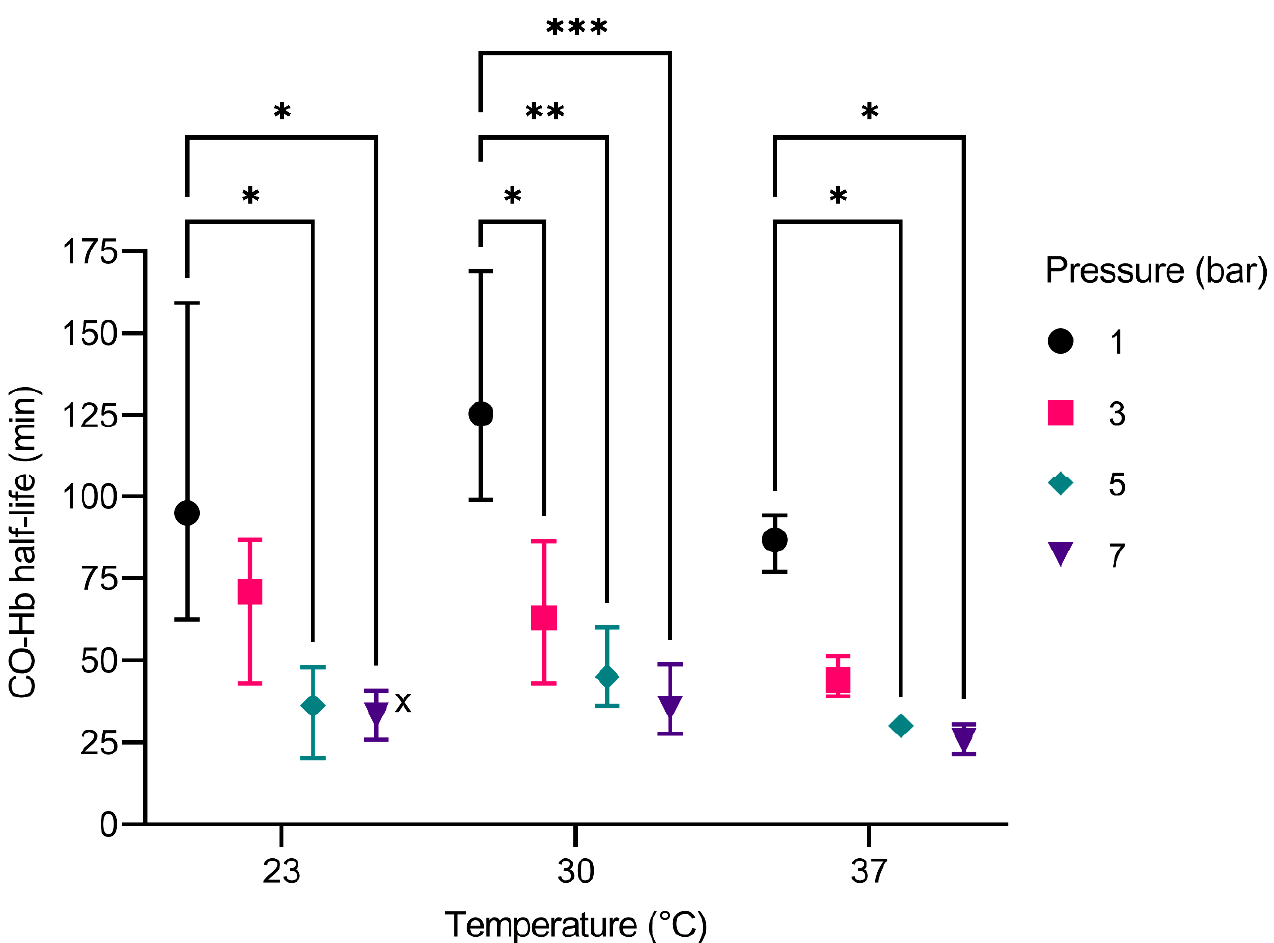
Figure 5. CO-Hb half-life of the revised BO dependent on temperature, and pressure. The whiskers represent the highest and lowest values of the corresponding experiments. (*) p ≤ 0.05, (**) p ≤ 0.01, (***) p ≤ 0.001. (x) One experiment was excluded due to extensive foam formation inside the BO.